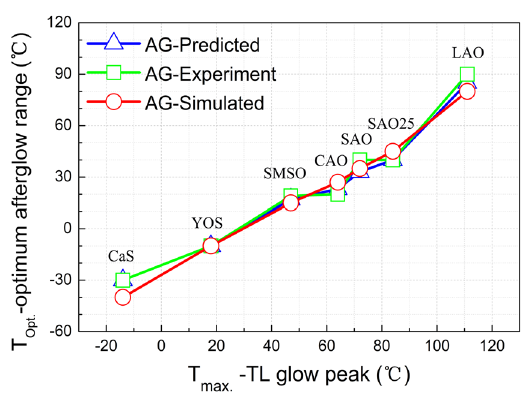
Figure 8. Comparison of the optimum afterglow temperature (T opt. ) and the temperature of the TL glow peak (T max. ) from the afterglow simulation (AG-Simulated), experimental afterglow measurements (AG-Experiment) and the predicted afterglow output from TL measurements at various temperatures (AG-Predicted). Each data point stands for a specific phosphor, namely, CaS, YOS, SMSO, CAO, SAO, SAO25, and LAO phosphor from left to